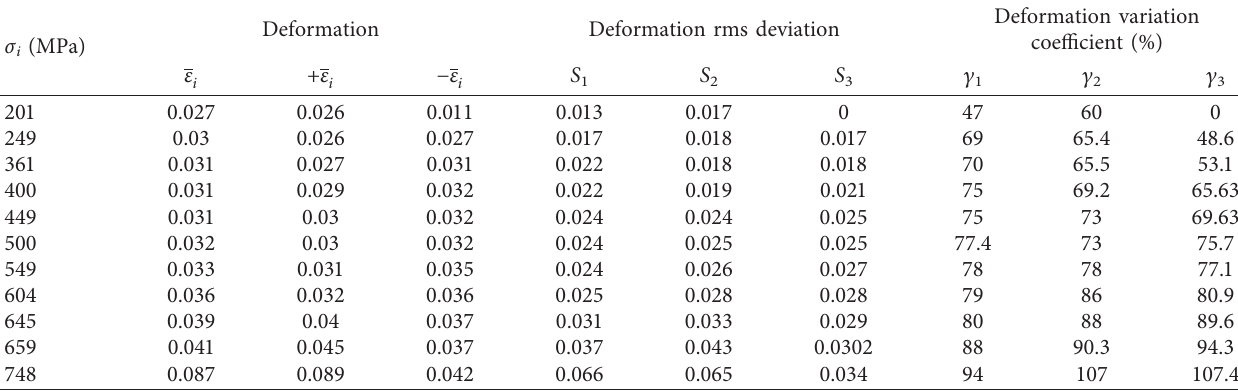
Table 8: Experimental data characterizing the microplastic deformation of deposited samples of steel 530H40 after heat treatment according to mode III (group III).